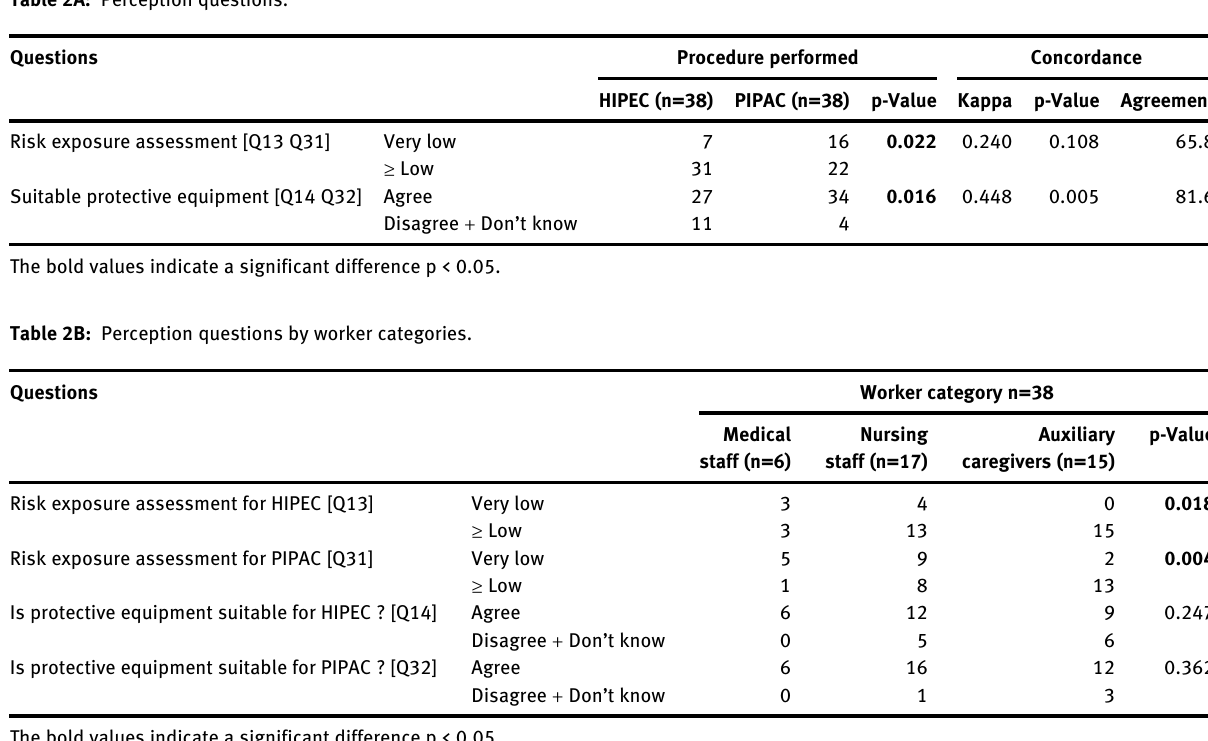
Table  A: Perception questions.